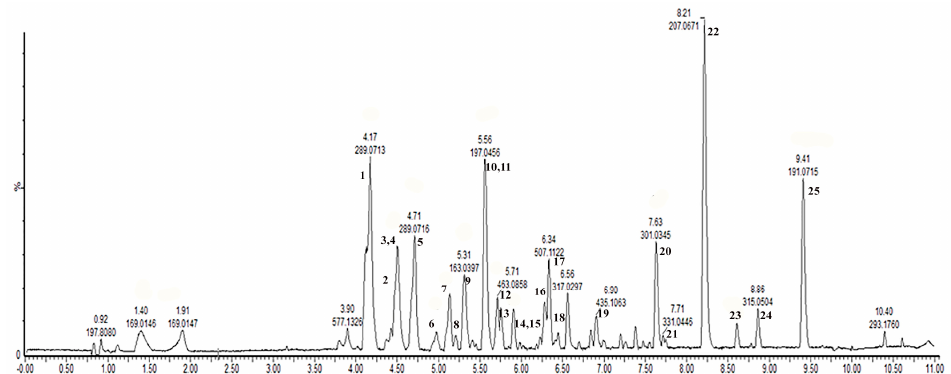
Figure 1. Base peak total ion chromatogram of the wine fraction (Fr 2 SySFV) obtained by an MS E data collection technique method using ultra performance liquid chromatography coupled with time of flight mass spectrometry (UPLC-QTOF/MS E ) in negative electrospray ionization mode (ESI - ). Table 2. Identification of compounds present in the fraction Fr 2 SySFV by UPLC-QTOF/MS E .